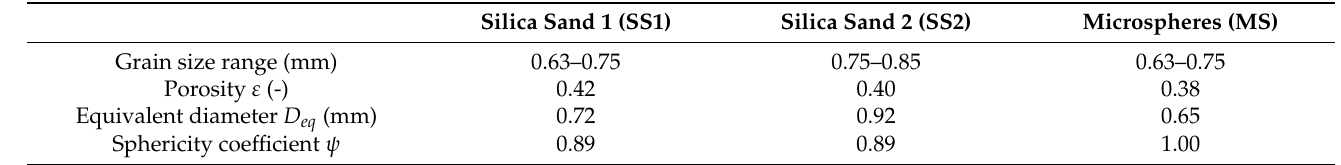
Table 1. Physical characteristics of the porous